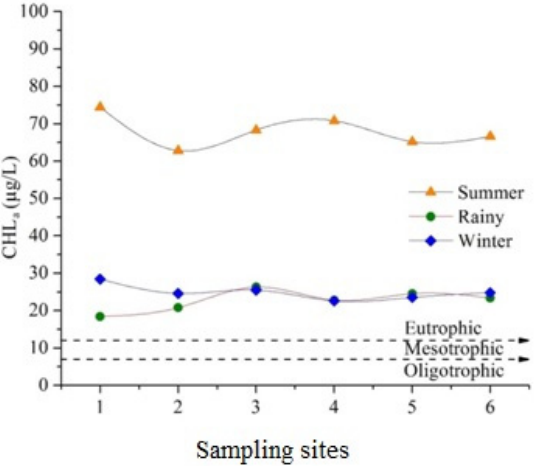
Fig. 2: Seasonal deviations in chlorophyll-a concentrations